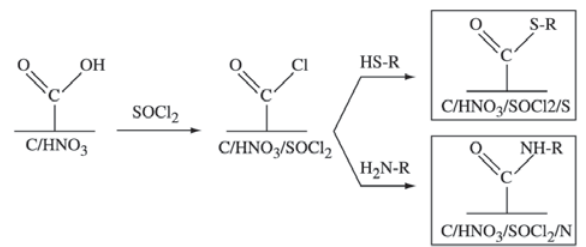
(8 h); 3 Scheme 2. Reactions used to functionalize the carbon surface with followed by reaction with; 2, NCH CH NH (EDA). S and N 2 2 2 2